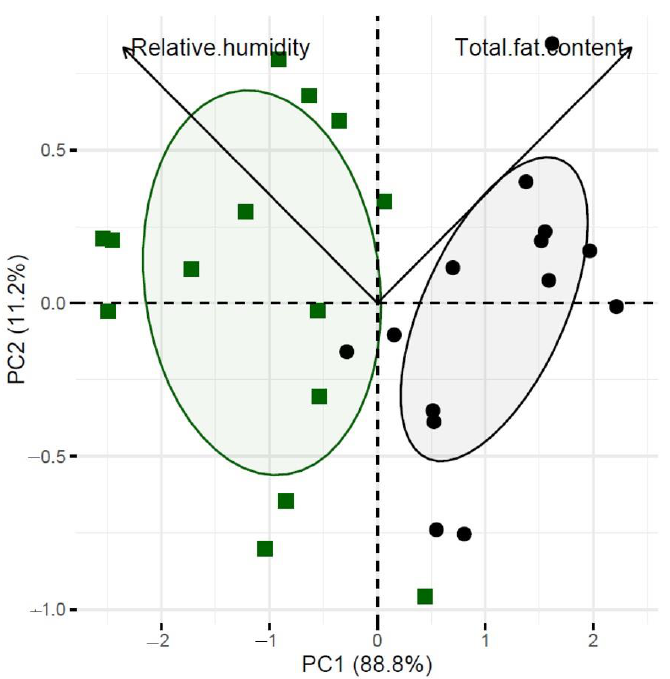
Figure 1. Differentiation of cv . Santulhana olives not subjected to frost ( ■ ) and subjected to frost (●): 2D PCA biplot based on the relative humidity and total fat